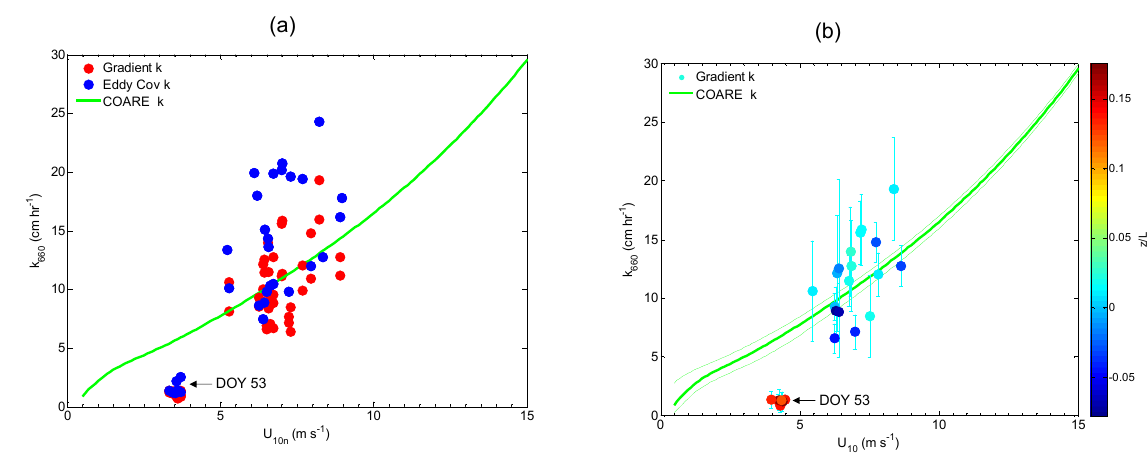
Figure 7. (a) DMS gas transfer velocities from GF and coincident EC as a function of wind speed adjusted to neutral stability ( U 10 n ) . The transfer velocity from the COAREG3.1 algorithm calculated for neutral stability with parameters A = 1.6 and B = 1.8 is shown by the green line. (b) GF transfer velocities as a function of U 10 , colour-coded by atmospheric stability ( z/L ). The transfer velocity from COAREG for mean conditions, together with the extremes of stability, are shown by the green lines, unstable (upper) and stable (lower). The cluster of points with positive stability with low K 660 are from DOY 53.